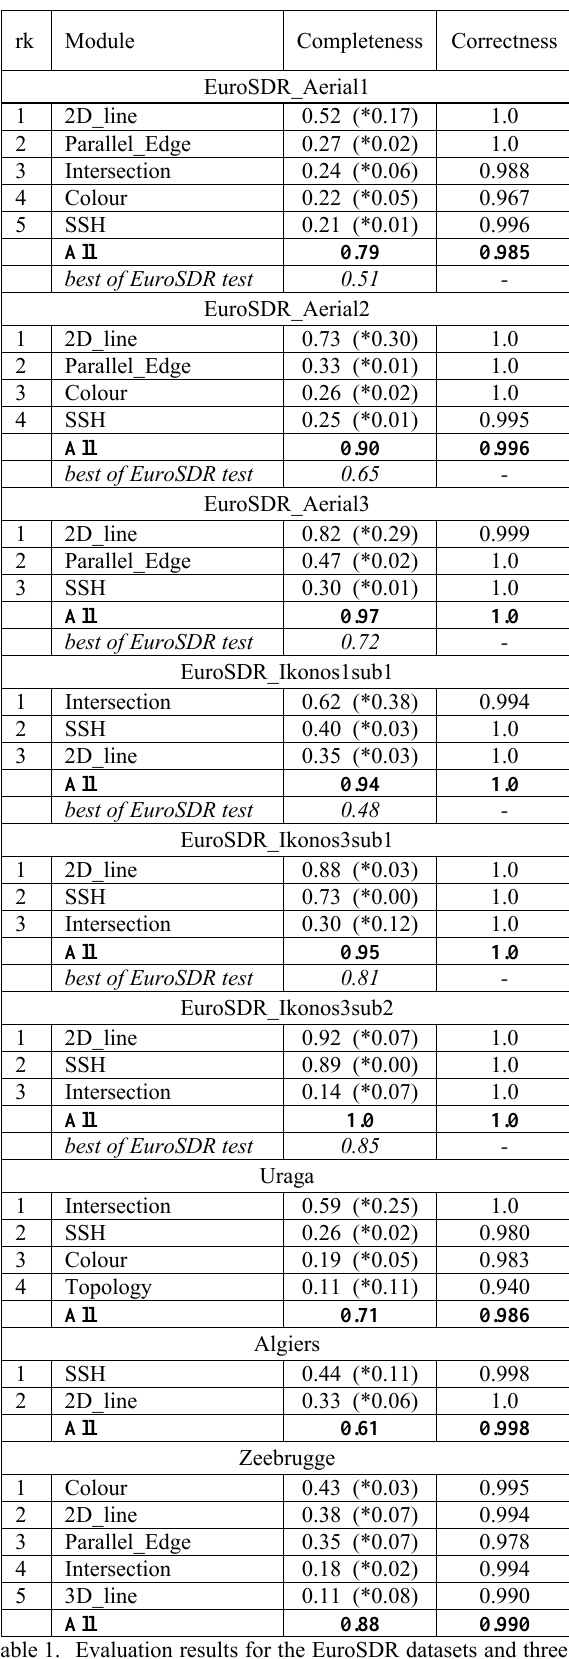
Table 1. Evaluation results for the EuroSDR datasets and three different topographic road databases. (*proportion of data exclusively validated by a